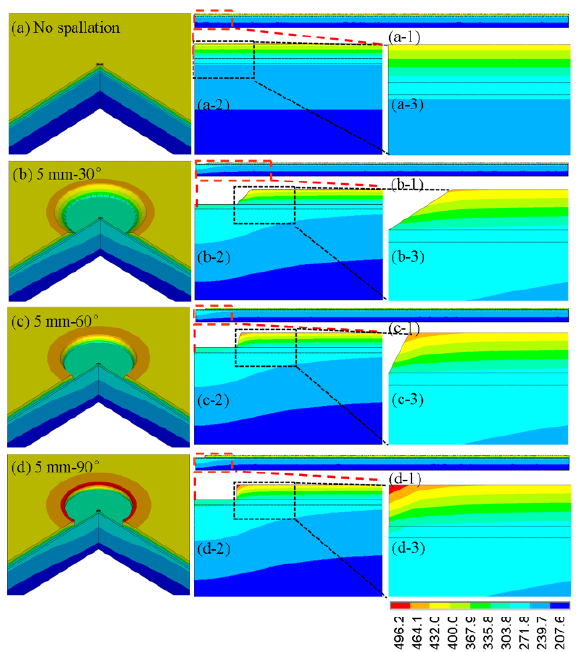
Fig. 4 Temperature distribution under different tilt angles with a identical spallation diameter 5 mm: (a) 0° (no spallation); (b) 30°; (c) 60°; and (d) 90°. (a-1)–(d-1) are the 2D temperature distribution corresponding to the model (a)–(d), respectively. (a-2)–(d-2) are detailed indications of the red dashed frame. (a-3)–(d-3) are detailed indications of the black dashed